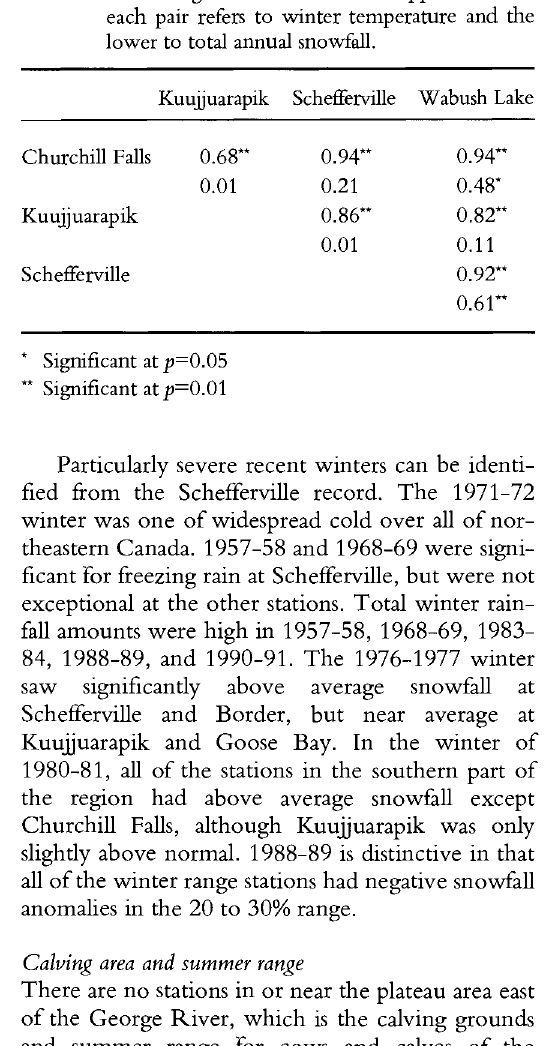
Table 2. Interstation correlations (f) for winter range of the George River Herd. The upper value in each pair refers to winter temperature and the lower to total annual